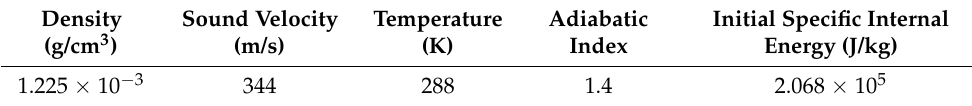
Table 2. Material parameters of air.